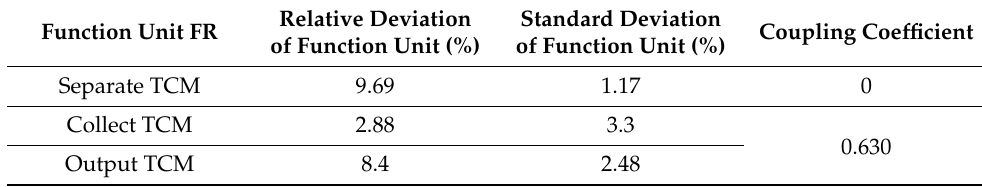
Table 2. Characteristic coefficients of function